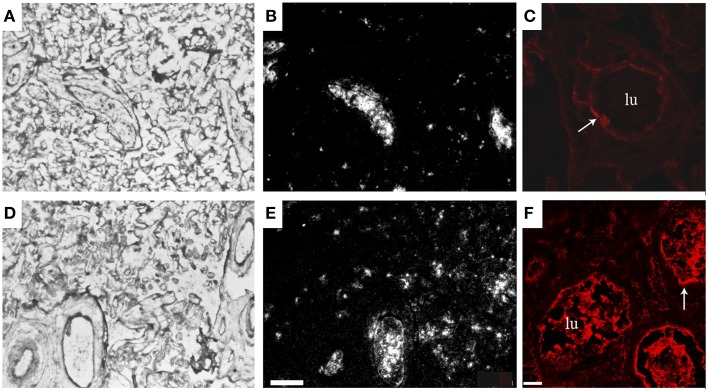
Increased placental expression of HbF in preeclampsia. Representative images from in situ hybridizations of human placenta, displaying the villous section of the placenta. HbF mRNA expression (α-chain) in a control placenta shown as light field image (A) and as dark field image (B), and in a preeclamptic placenta shown as light field image (D) and as dark field image (E). HbF expression was especially seen in and around blood vessels, with several scattered cells detected in the villous section of the preeclamptic placenta. HbF protein expression (γ-chain) is shown with a red fluorescent marker in control placenta (C) and in preeclamptic placenta (F). In the preeclamptic placenta there is a strong expression of HbF in the vascular lumen (lu), but HbF is also expressed in the vascular endothelium (arrow) as well as in the extravascular section of the villous stroma. The placenta from control shows no expression of HbF in the vascular lumen (lu), but expression is detected in the vascular endothelium (arrow). Scale bars for (A,B,D,E) = 100 μm and for (C,F) = 25 μm. Modified from Centlow et al. (2008).